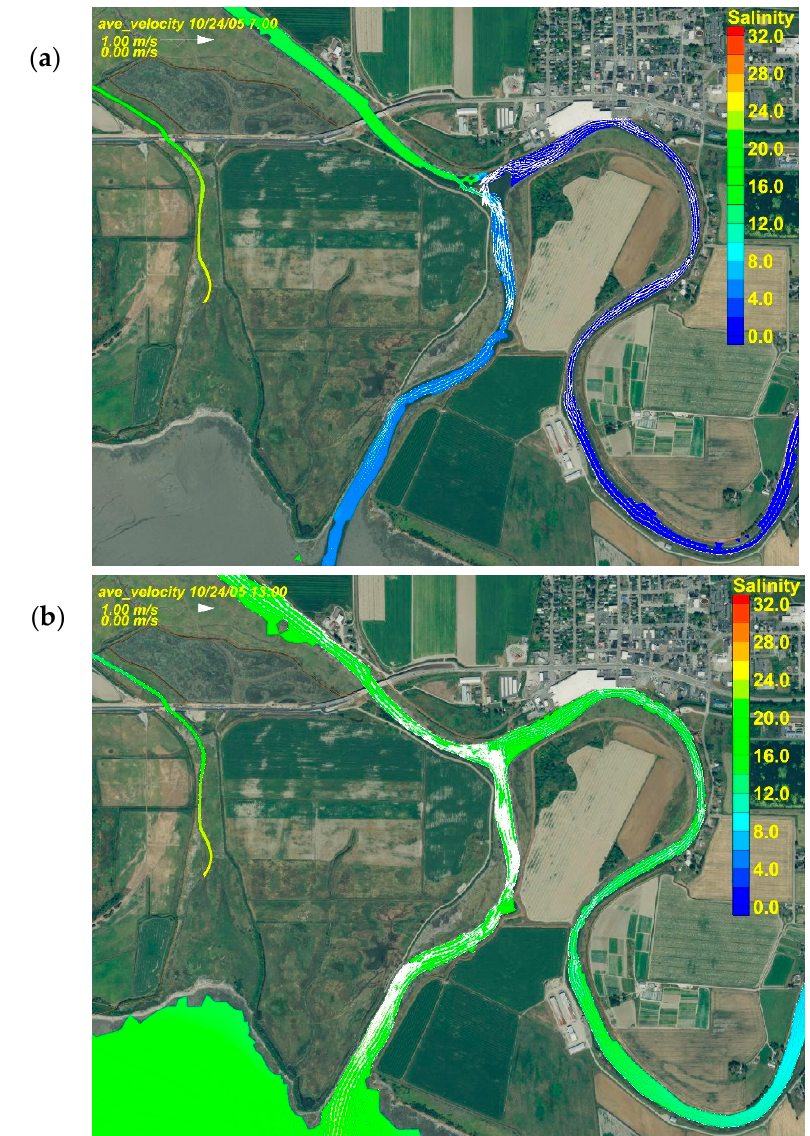
Figure 9. Horizontal distribution of salinity at low tide (07:00: a ) and high tide (13:00: b ) for the baseline scenario on 24 October 2005.